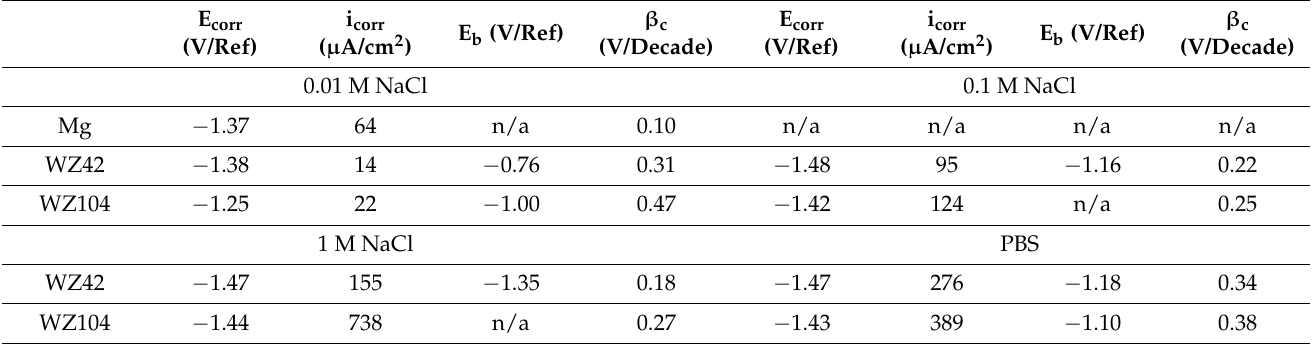
Table 2. Electrochemical parameters calculated from fitting of the potentiodynamic